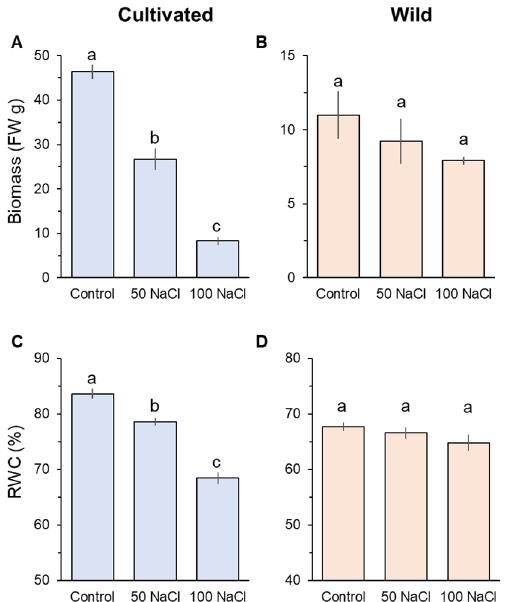
Figure 1. Whole-plant biomass change in fresh weight measured from cultivated ( A ) and wild ( B ) rice species. Shoot relative water content (RWC) of cultivated ( C ) and wild rice species ( D ). Seedlings were exposed to 0 (control), 50, or 100 mM NaCl for four weeks. Different letters indicate significant differences ( p < 0.05, one-way ANOVA followed by LSD tests). Mean ± SE ( n = 6). Physiological characteristics were also affected only in cultivated rice in response to